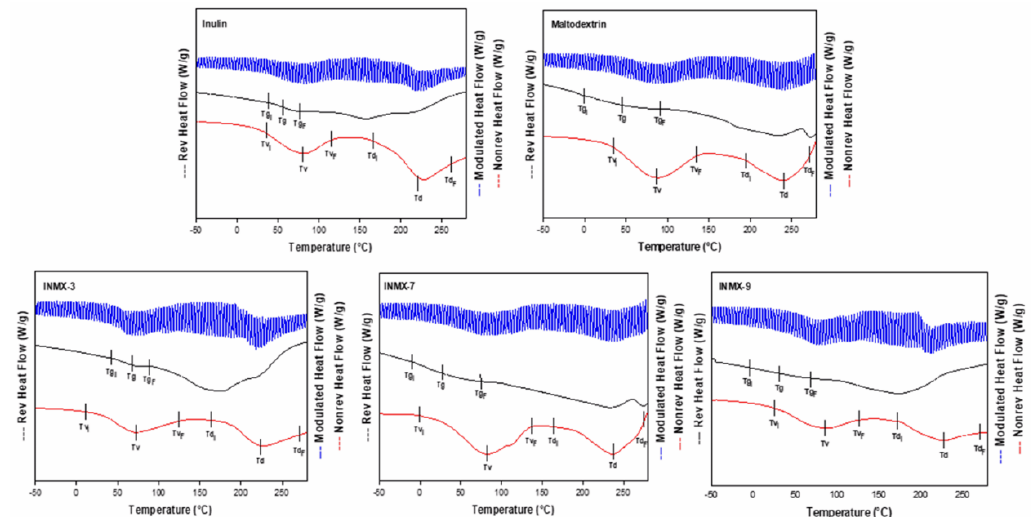
curves: on top (blue color) the total heat flow curve, in the middle (black color) the reversible heat flow curve, and on the bottom (red color) the non-reversible heat flow curve. Additionally, on each curve are indicated the beginning (T i ), the peak value, and the ending (T f ) of the identified thermal event.